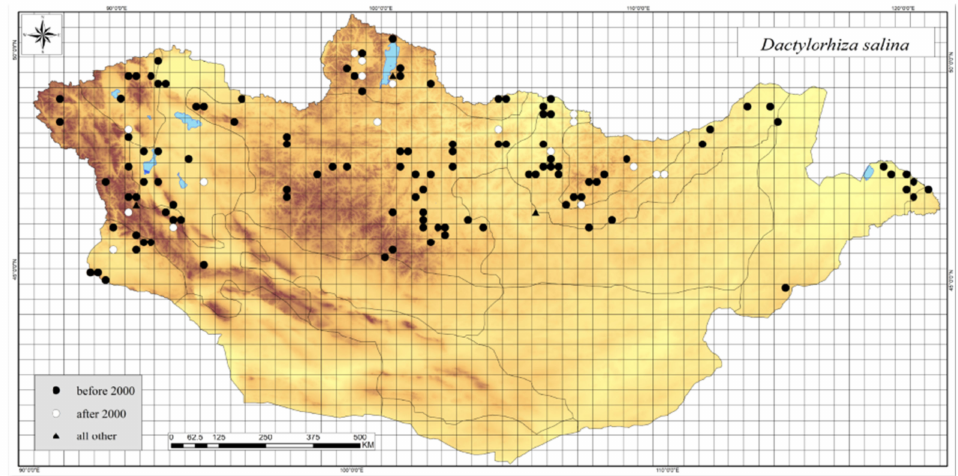
Figure A10. Distribution map of Dactylorhiza salina in Mongolia.